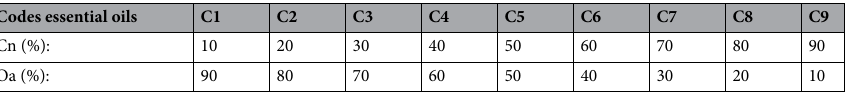
Table 1. Combination codes with proportions of the two essential oils. Cn, C. nardus ; Oa, O. americanum; %,